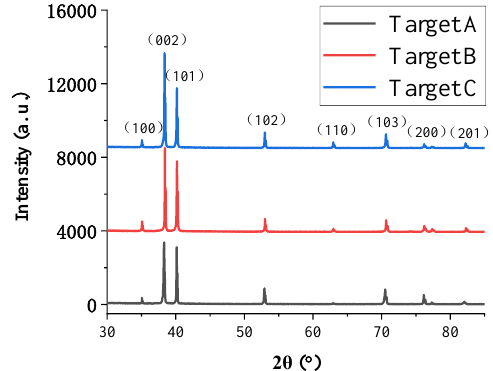
Figure 1. XRD patterns of Ti targets with different purities.